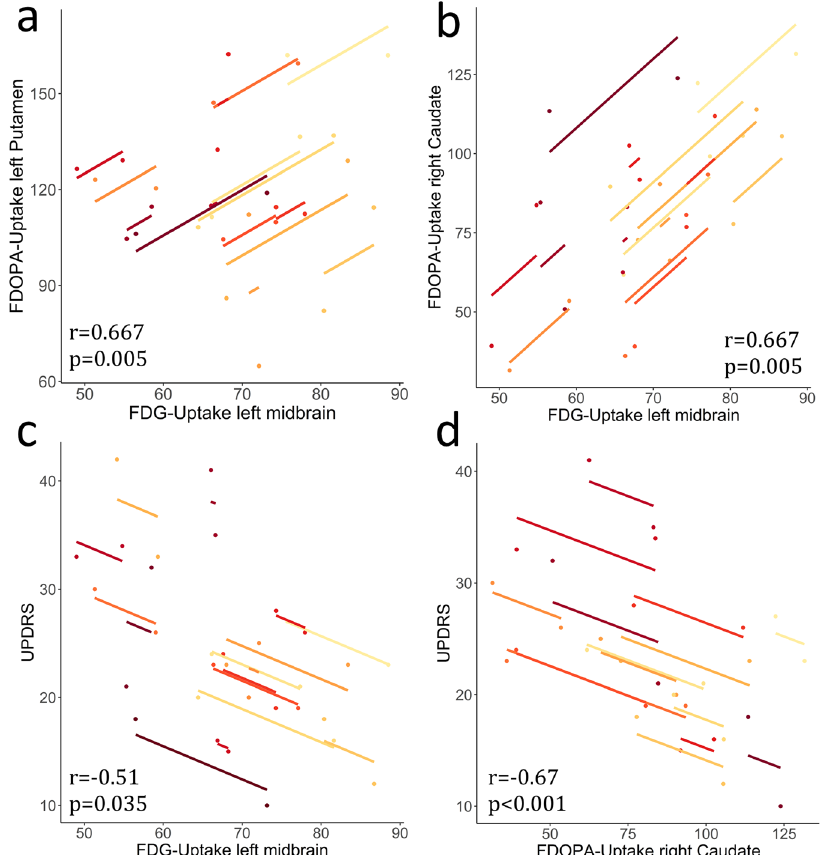
Fig. 3 Repeated measure correlations between changes in FDG or FDOPA uptake and clinical deterioration. Rmcorr plots indicating a signi fi cantly associated decline in tracer uptake of midbrain and striatal clusters. Each colored dot represents one of the two separate variables of normalized tracer uptake (proportional scaling) for a patient; observations from the same patient are similarly colored 25 . The corresponding lines represent the rmcorr fi t for each participant. Positive slopes indicate a positive linear correlation and vice versa. a Concomitance in progression of hypometabolism in left midbrain and dopaminergic de fi cit of the left putamen ( r = 0.667, p = 0.005) and b likewise, between left midbrain and right caudate ( r = 0.667, p = 0.005). Correlation between worsening in UPDRS-III OFF and changes in glucose metabolism in left midbrain ( c ) ( r = − 0.51, p = 0.035) and d increasing dopaminergic de fi ciency of the right caudate ( r = − 0.67, p <